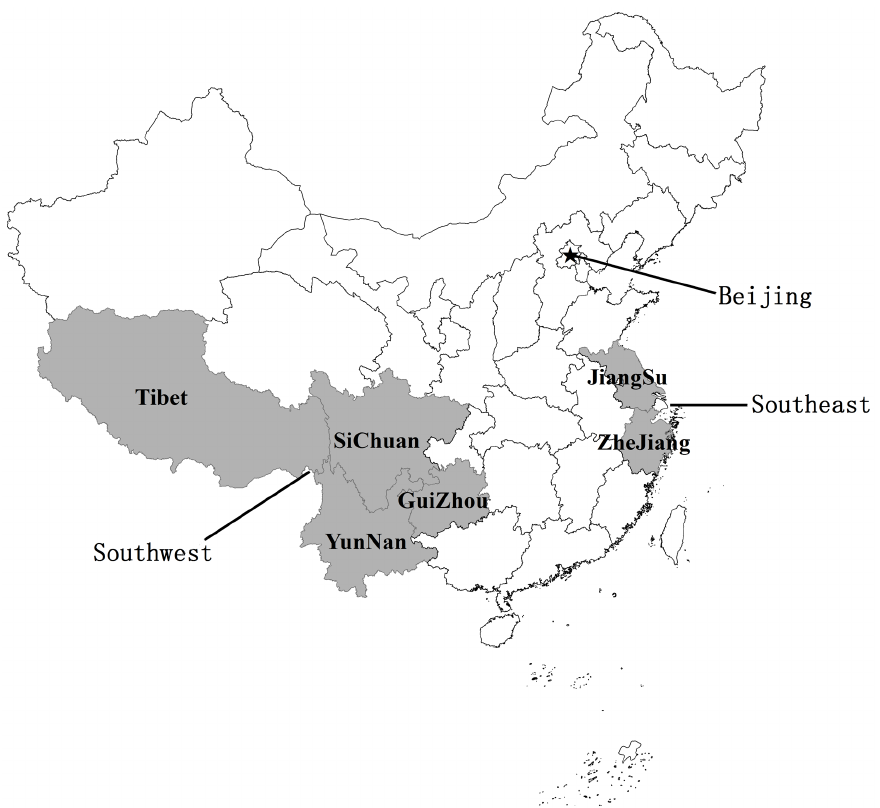
Figure 1. Location of samples collected for screening of three human parvoviruses (HPAVs) in China.